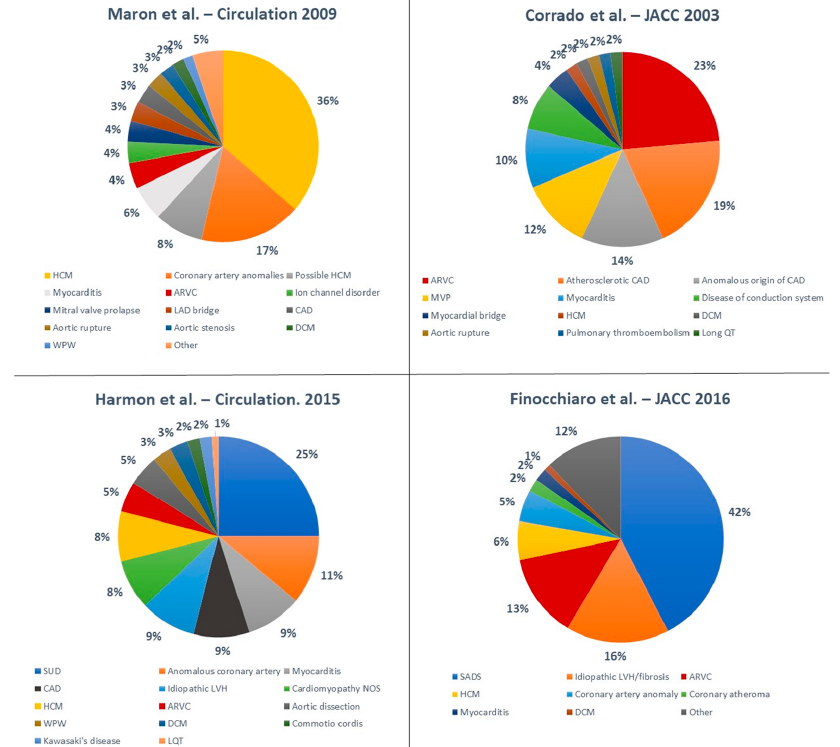
Figure 3. Summary of main studies describing the causes of SCD in athletes. Abbreviations: ARVC—arrhythmogenic right ventricular cardiomyopathy; CAD—coronary artery disease; DCM—dilated cardiomyopathy; HCM—hypertrophic cardiomyopathy; LAD—left anterior de- scending artery; LQT—long QT; LVH—left ventricular hypertrophy; MVP—mitral valve prolapse; NOS—not otherwise specified; SADS—sudden arrhythmic death syndrome; SUD—sudden unex- plained death; WPW—Wolff–Parkinson–White